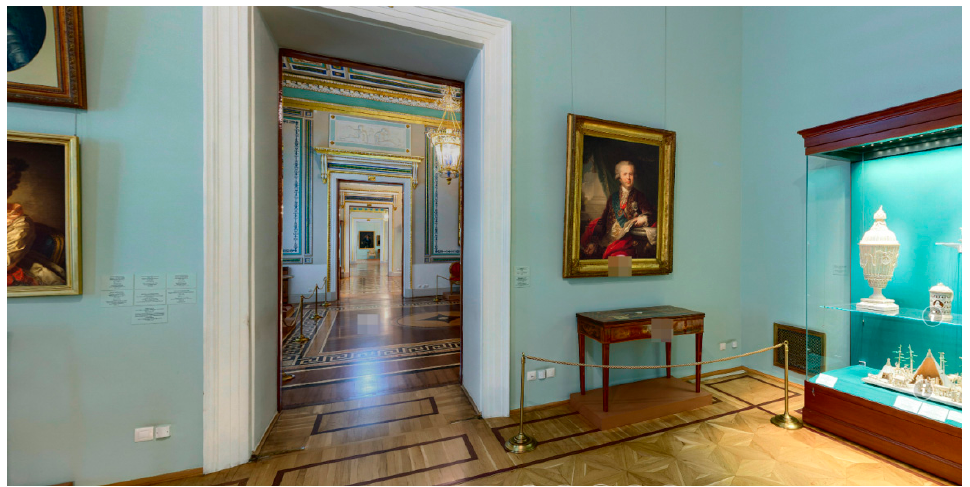
Figure 2. Enfilade arrangement of rooms in the Winter Palace of the State Hermitage Museum. Photo by the authors.